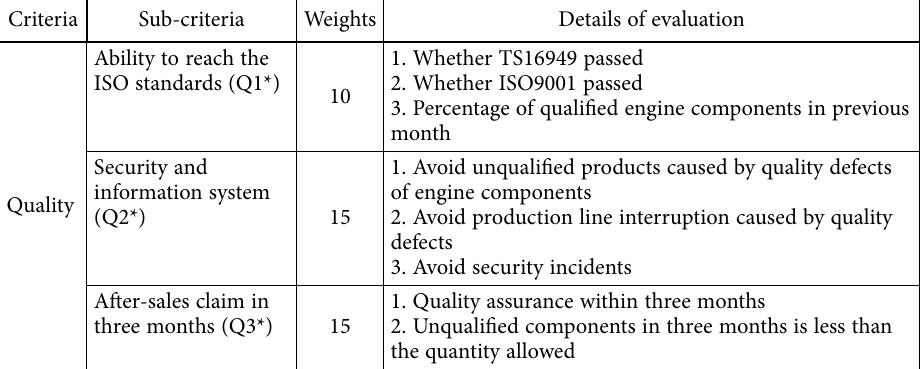
Table 7. Weights and evaluation criteria for engine components